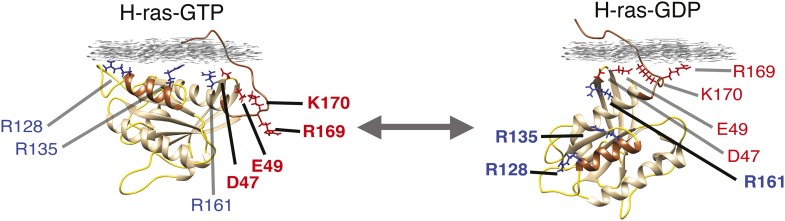
Nucleotide-dependent H-ras conformers on the membrane.Computational modeling-derived structures of the predominant H-ras-GTP- (left) and H-ras-GDP- (right) conformers on the membrane. Conformer stabilizing residues R128,R135 on helix α4 and R169,K170 in the hypervariable region (hvr), as well as switch III region residues of helix α5 (R161) and β2-β3-loop (D47,E49) are indicated. Color-coding as in Figure 1A.